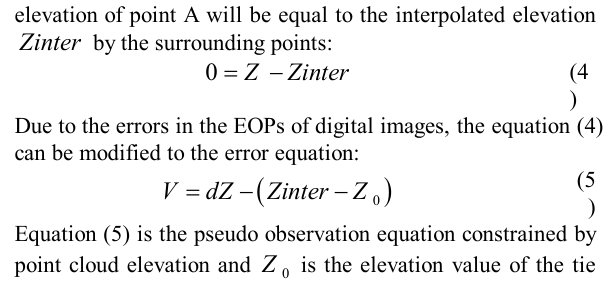
Equation (5) is the pseudo observation equation constrained by point cloud elevation